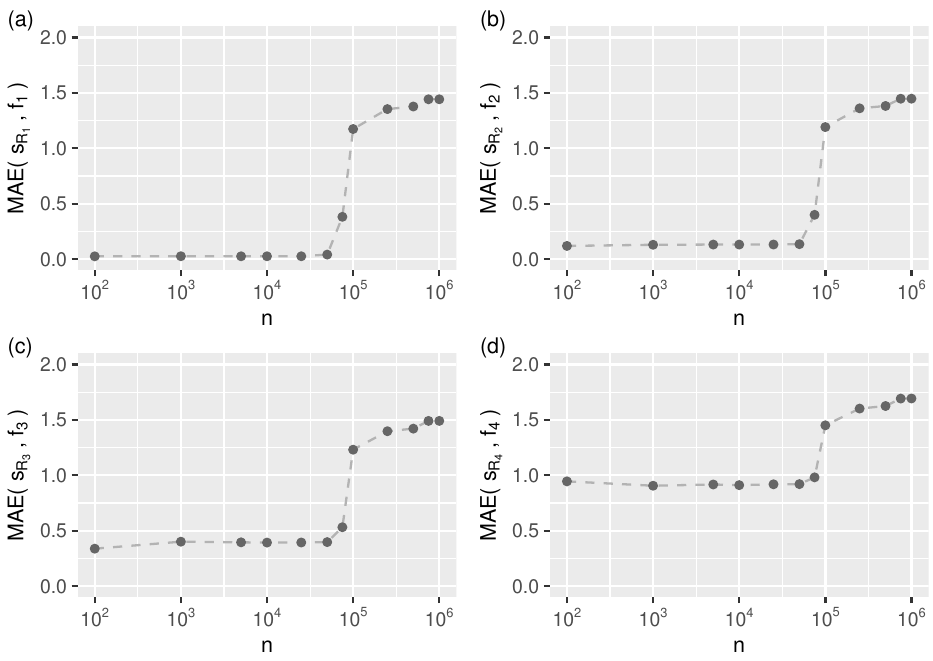
Figure 4. Auto-segmentation related limitations of the reference algorithm: approximation mean absolute error (Equation (28)) as a function of input stream length ( n ) for all test streams, ( a – d ) f 1 – f 4 . For n > 6 × 10 4 one needs to specify the number of spline segments (knots) manually. For longer streams, we need to specify the number of smoothing spline segments (knots) manually. As shown in Figure 5, we can expect accurate approximations for all test streams when using more than 4 × 10 3 knots.